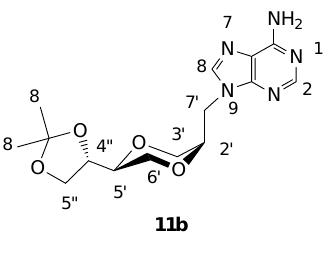
Figure 9. Structure 11b